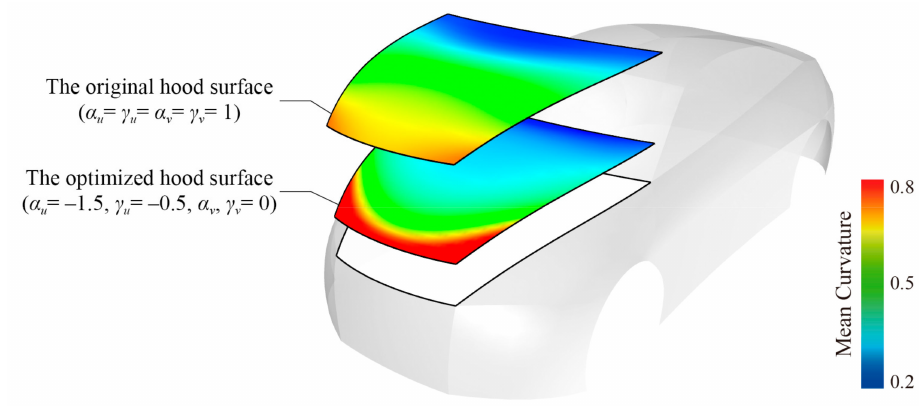
Figure 17. The change in mean curvature on the hood surface before and after